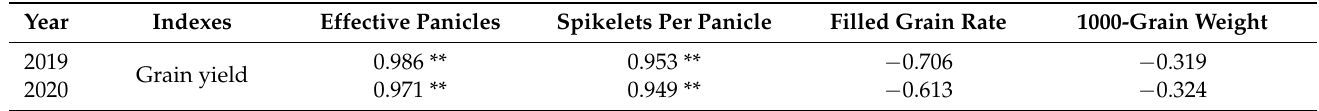
Table 14. Correlation between yield and yield